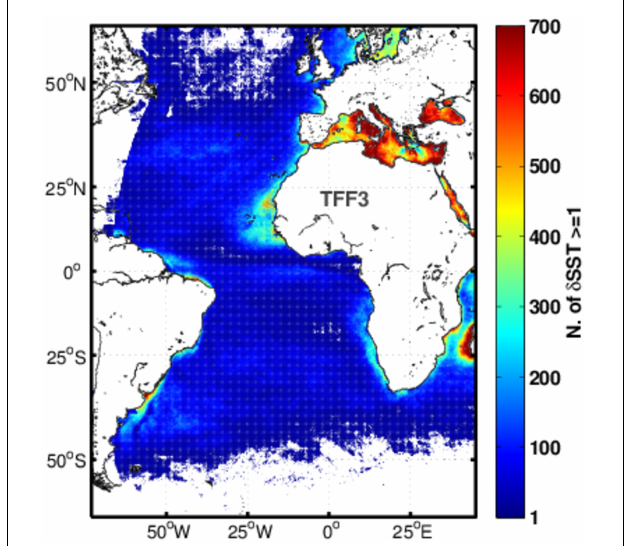
FIGURE 6 | Occurrences of diurnal warming of 1 K and larger, estimated from hourly SEVIRI SST retrievals between 2006 and 2011. (Reproduced by permission under CC BY 3.0 from